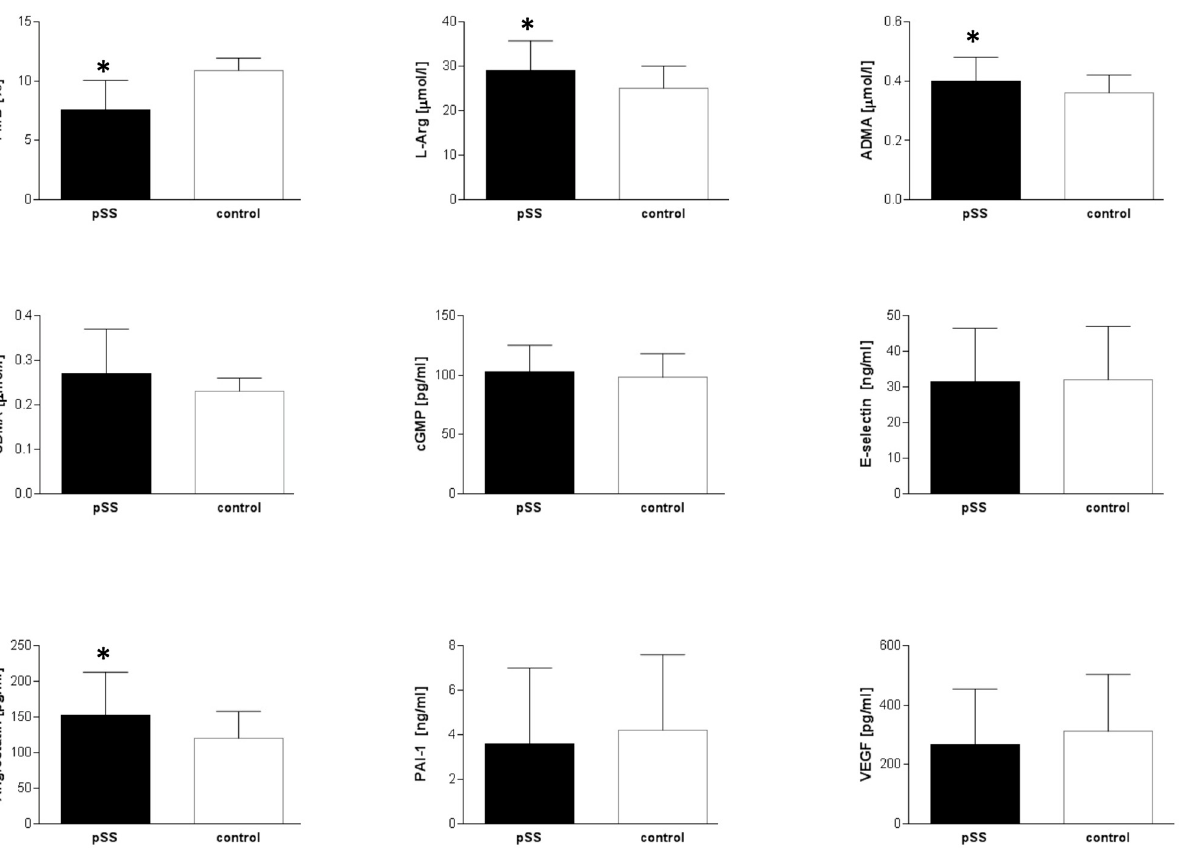
Table 3. Disease-specific variables associated with FMD and biomarkers levels.